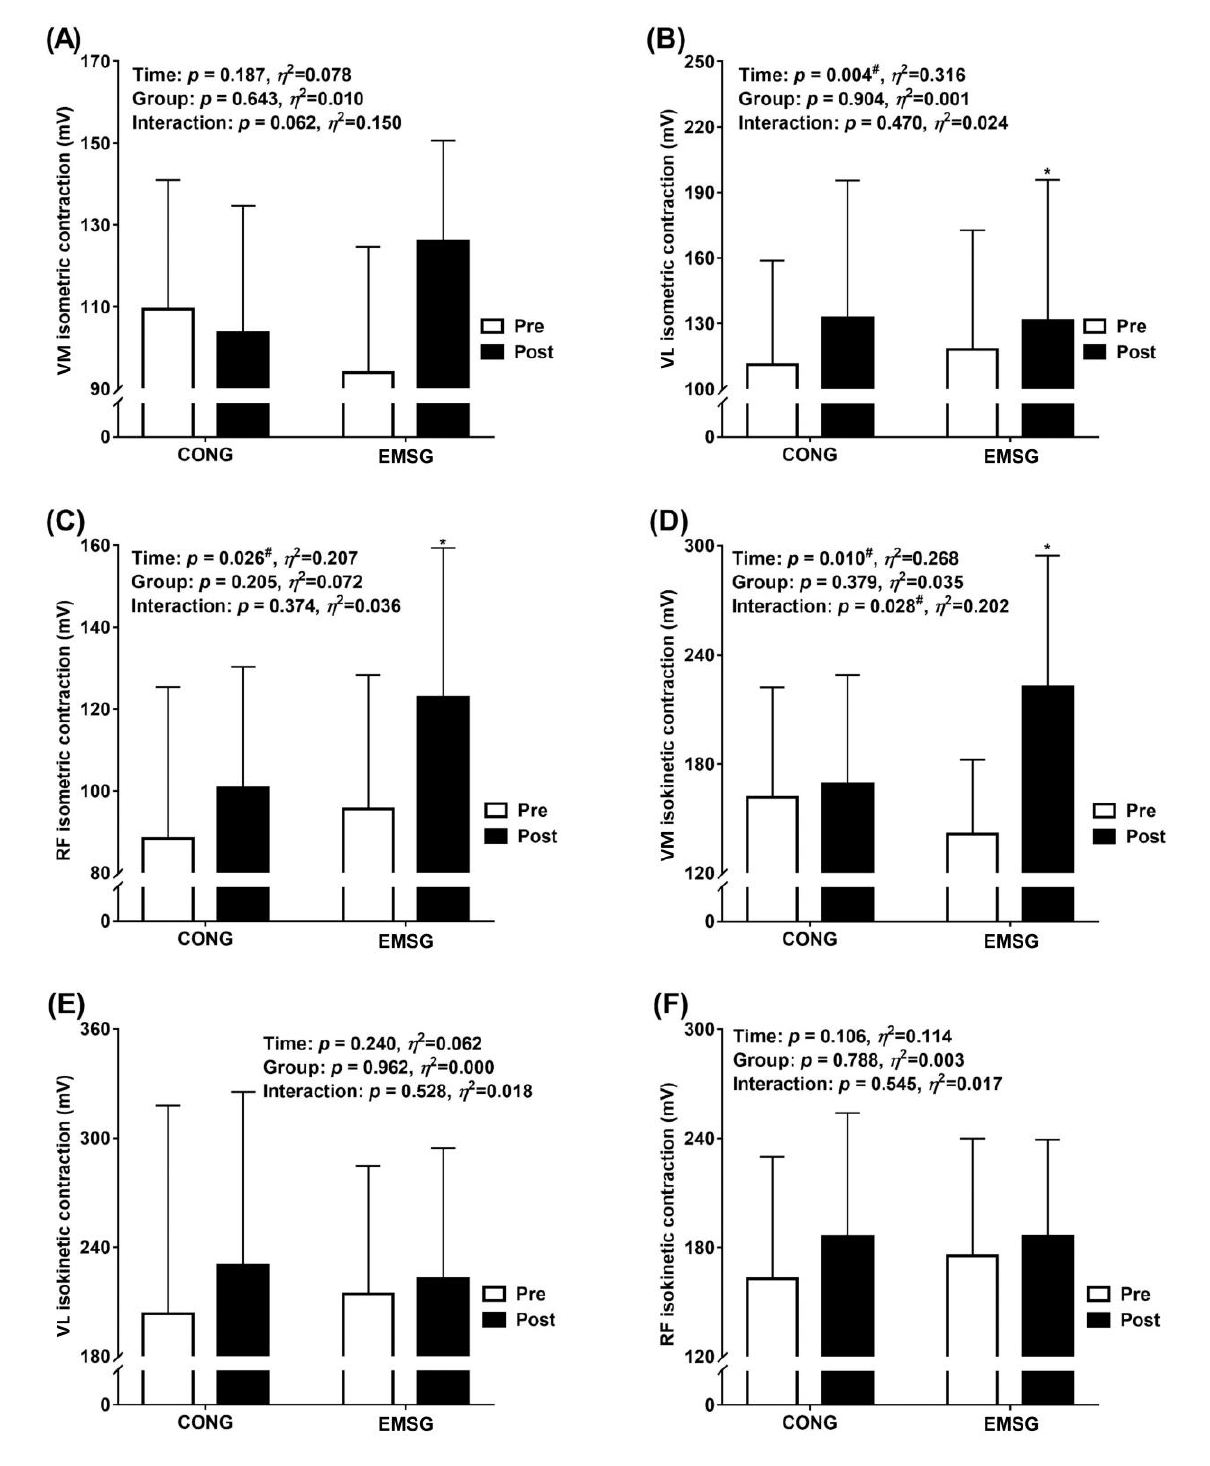
Figure 6. The rehabilitative exercise programs’ effects on muscle activity of VM, VL, and RF during iso- metric and isokinetic contraction. ( A ) Compared in VM during isometric contraction. ( B ) Compared in VL during isometric contraction. ( C ) Compared in RF during isometric contraction. ( D ) Compared in VM during isokinetic contraction. ( E ) Compared in VL during isokinetic contraction. ( F ) Compared in RF during isokinetic contraction. control group; CONG, electro muscle stimulation group; EMSG, vastus medialis; VM, vastus lateralis; VL, rectus femoris; RF. # p < 0.05: main effect or interaction; * p < 0.05: pre- and